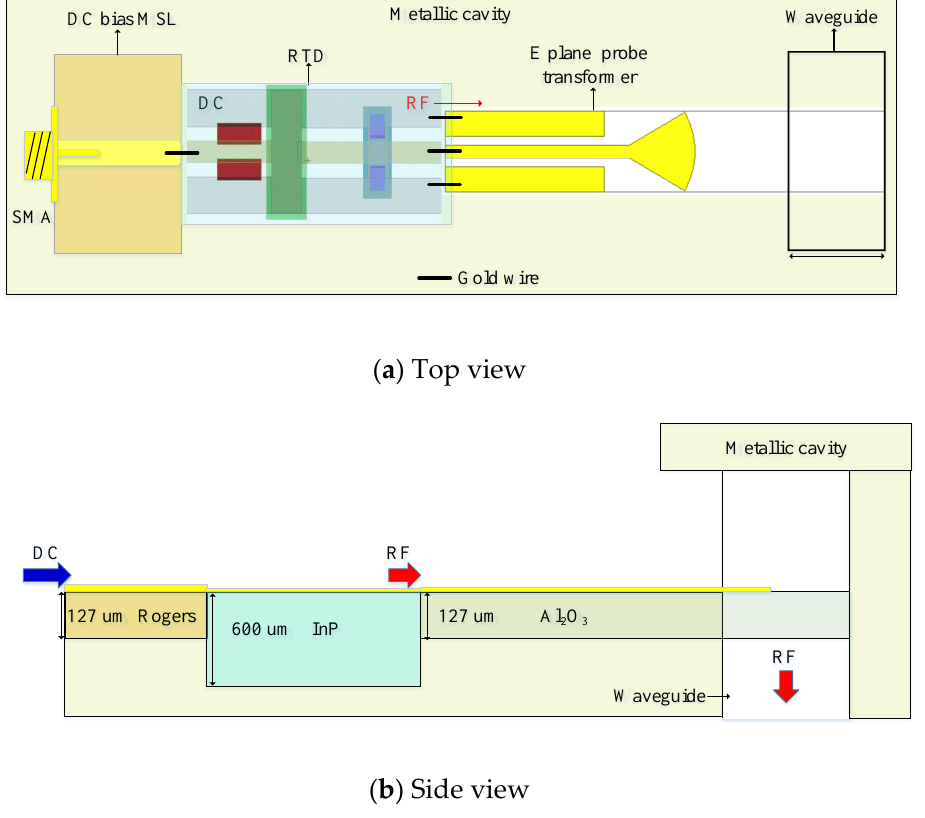
Figure 5. The packaged resonant tunneling diode (RTD) configuration.